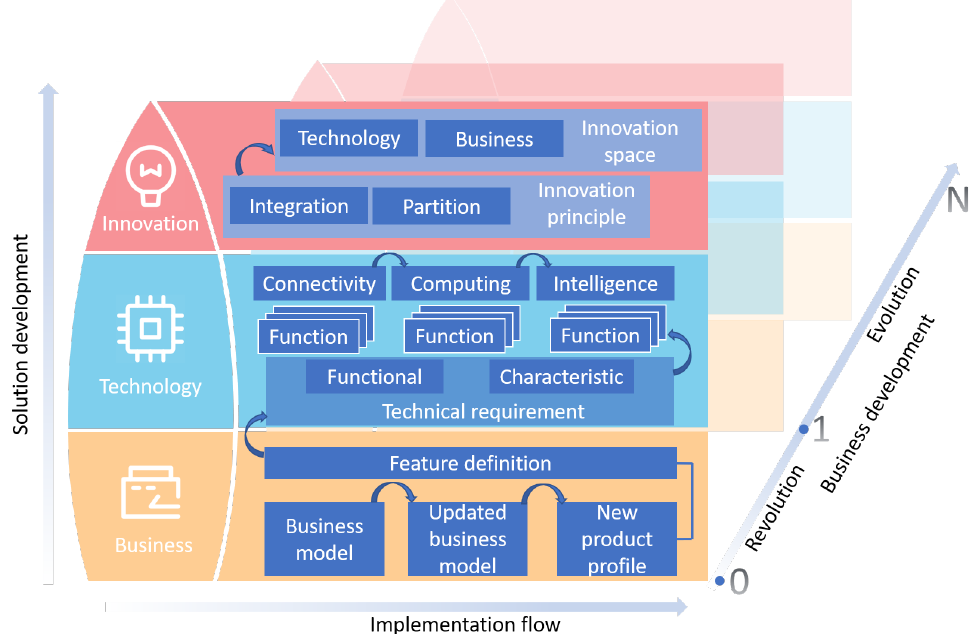
Figure 2. A reference framework for SMEs to accomplish digital transformation with enabling tech- nologies such as IoT and cloud computing. It features a three-stage iteration that covers consideration of business, technology, innovation, and three dimensions of development flows. The framework can be referenced by business stakeholders as a guideline to formulate a technology development road map and to trigger business